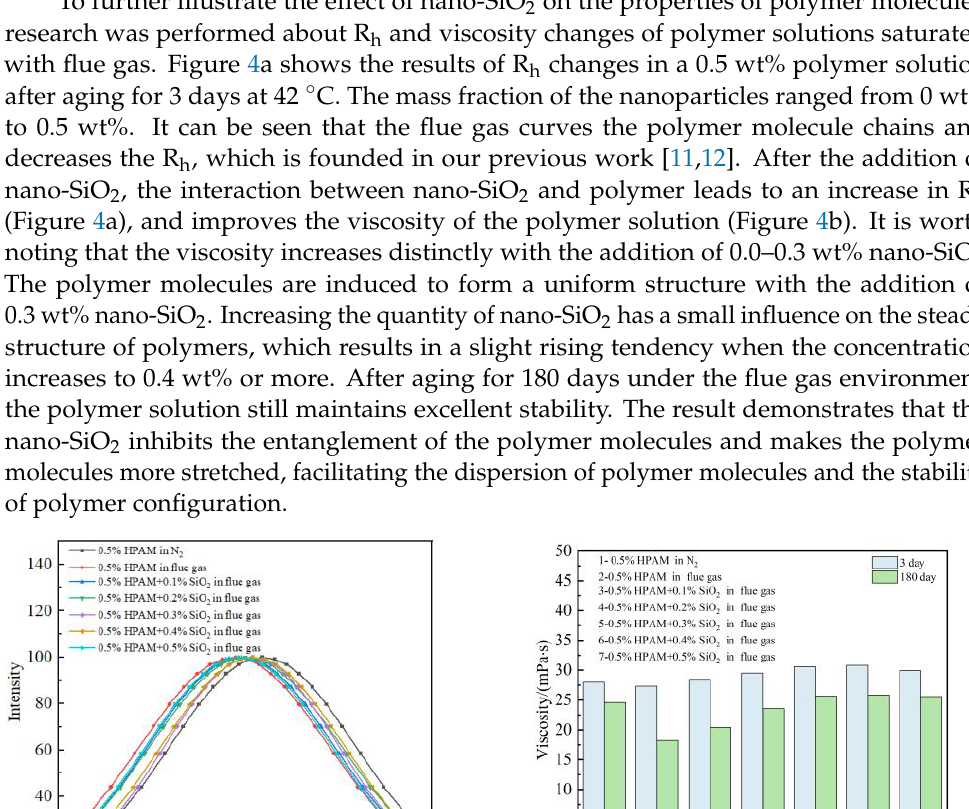
( b ) Figure 5. Effect of nano-SiO 2 on gelation performance of polymer gel: ( a ) Gelation time; ( b ) Gel strength. 2.2.3. Long-Term Stability at Elevated Flue Gas Pressure To study the influence of nanoparticles on the long-term stability of gels, the strength of gel under high-pressure flue gas is further investigated, as shown in Figure 6. The strength of gel without the addition of nano-SiO 2 decreases to different degrees under dif- ferent flue gas pressures and performs seriously with the increase in pressure due to the comprehensive effect of CO 2 and O 2 composed in flue gas [11,12]. In contrast, the strength of the gel in the presence of nano-SiO 2 is improved under different flue gas pressures. With the increase in nano-SiO 2 concentration, the gel strength increases obviously. Taking 2 MPa